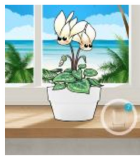
Figure 5. Images: Apple Watch.